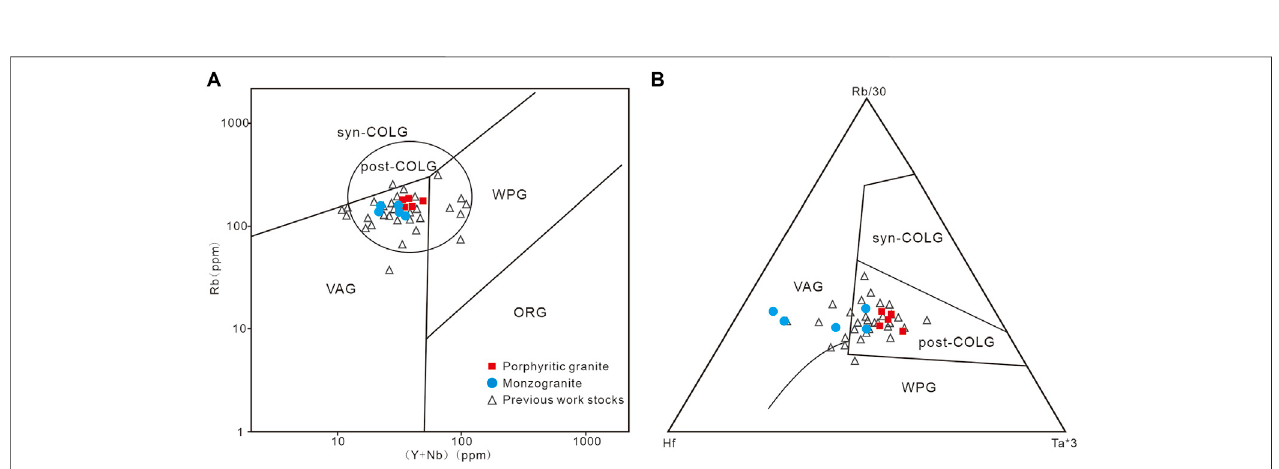
Frontiers in Earth Science |